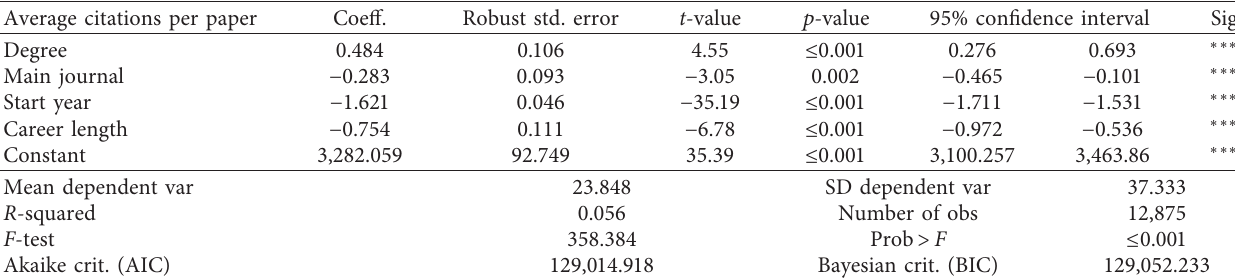
Figure 7: Scatter diagram and regression curve of correlation between average citations per paper and degree centrality. Table 3: Unary linear regression results of average citations per paper and degree